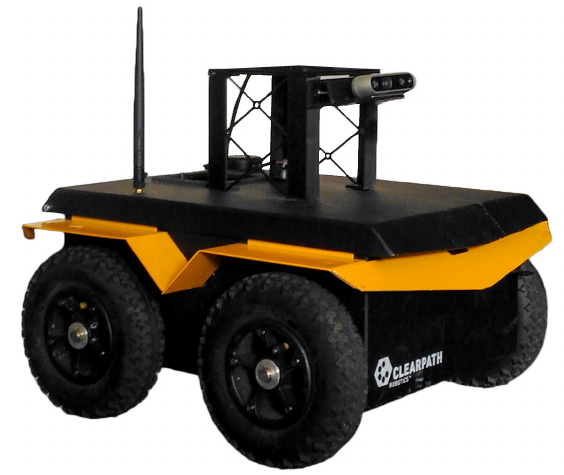
Figure 1. UGV Jackal from Clearpath Robotics endowed with an Intel RealSense